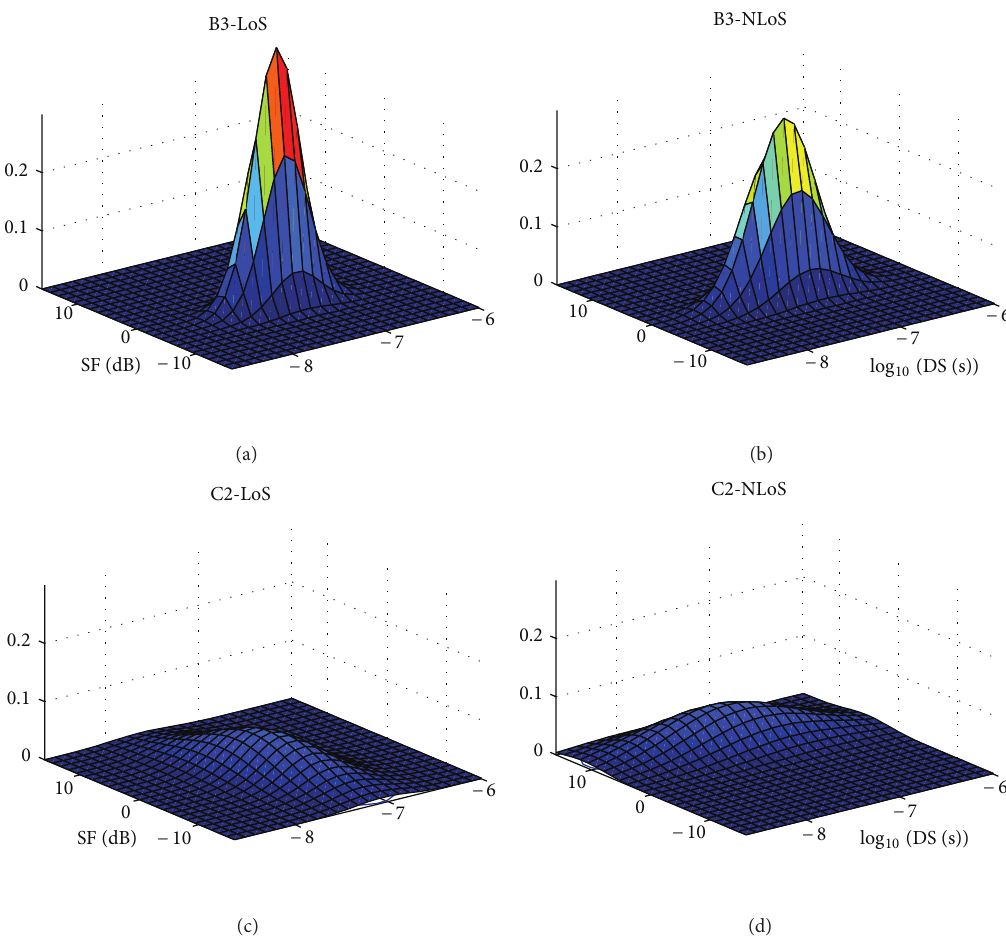
Figure 7: Comparison of joint (DS and SF) PDFs for B3 and C2 WINNER scenarios, for LoS and NLoS propagation.